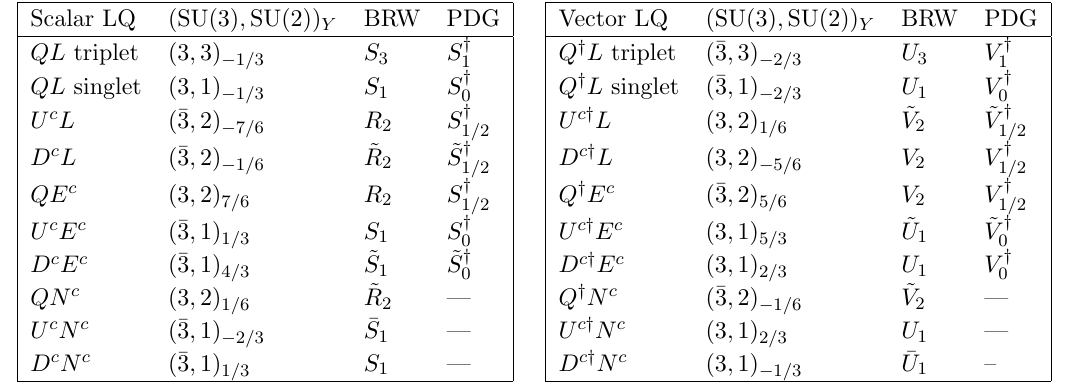
Table 13 . Alternative LQ names in the